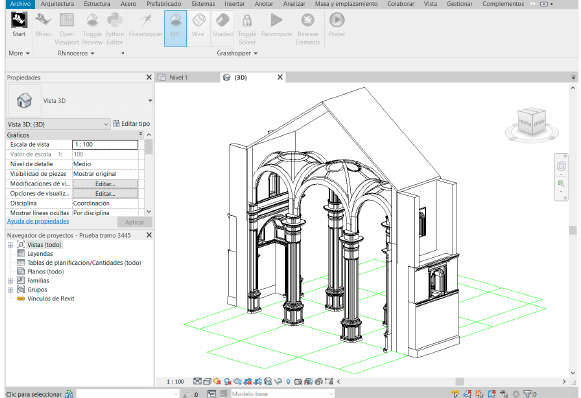
Figure 7. Partial model of the church imported into